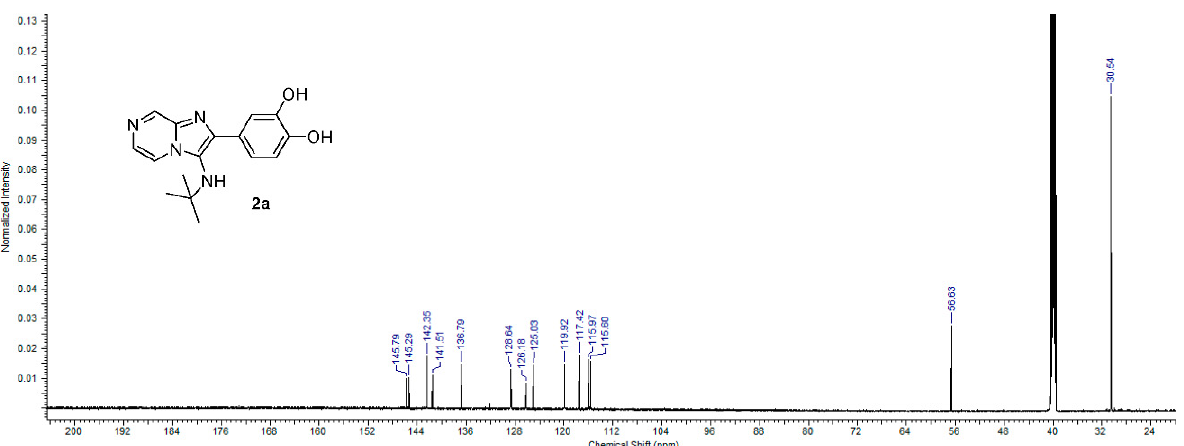
Figure 3. 1 H NMR spectrum of compound 2a.